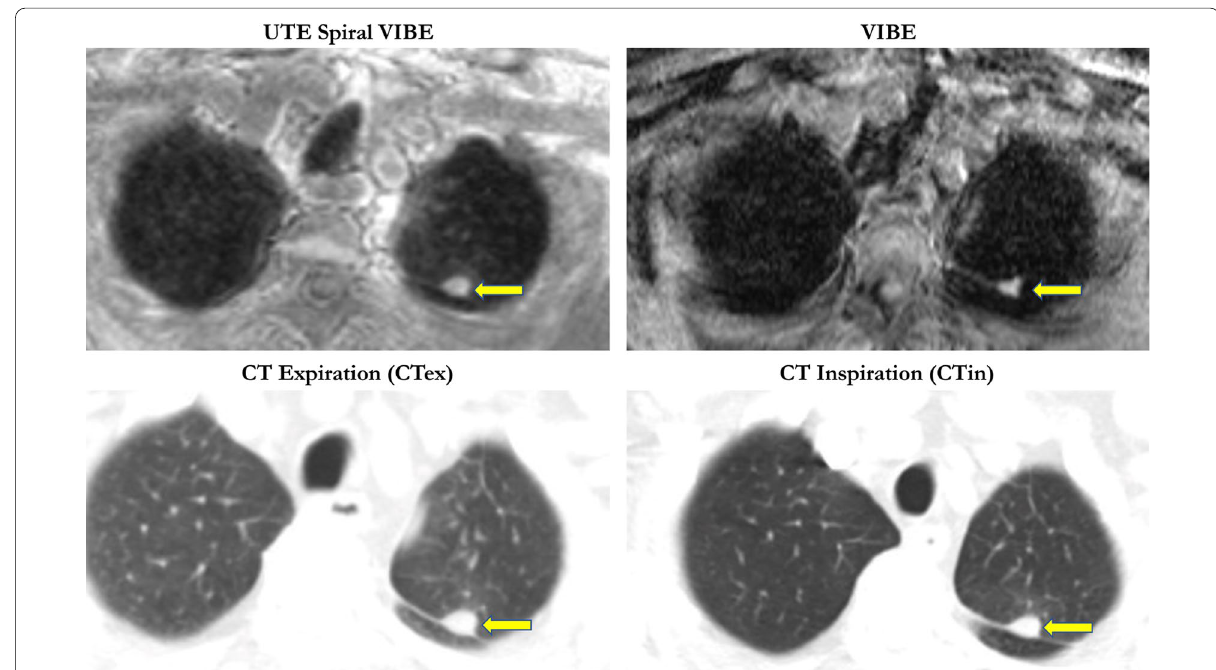
Fig. 3 Perifissural bronchial carcinoma in the upper lobe was detected in UTE Spiral VIBE, VIBE and CT imaging; (arrow; 15 mm)